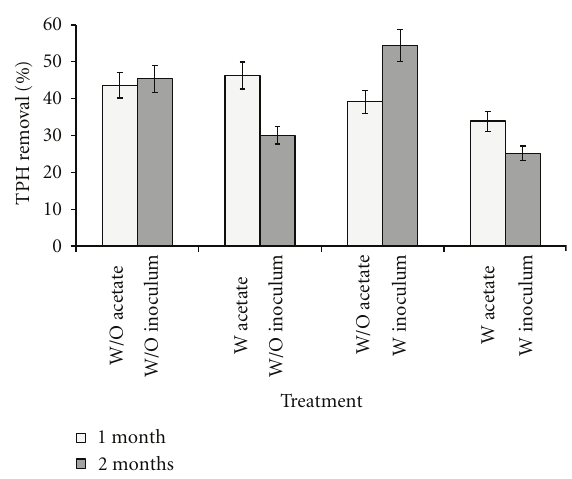
Figure 3: TPH removal in the anaerobic pretreatments in the presence (W) and absence (W/O) of sodium acetate and sulfate- reducing prokaryotes.